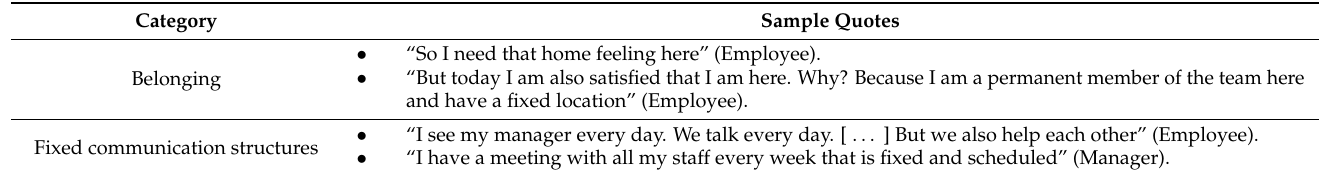
Table 2. Branch group (shortened